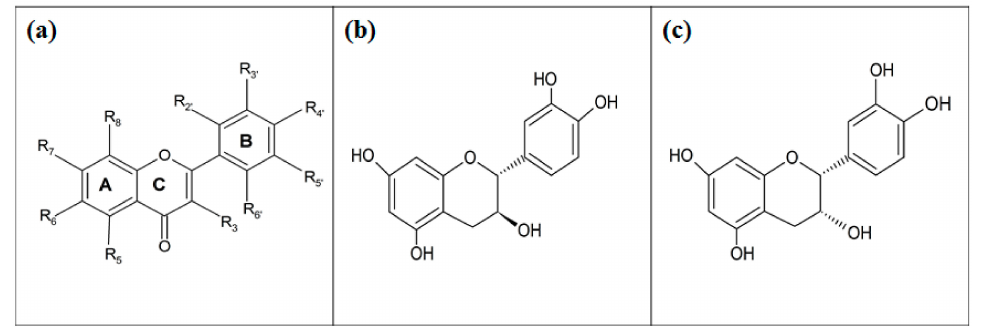
Figure 2. Structures of the tested flavonoids; ( a ) MN1-MN12, ( b ) (+)-Catechin (MN13), ( c )